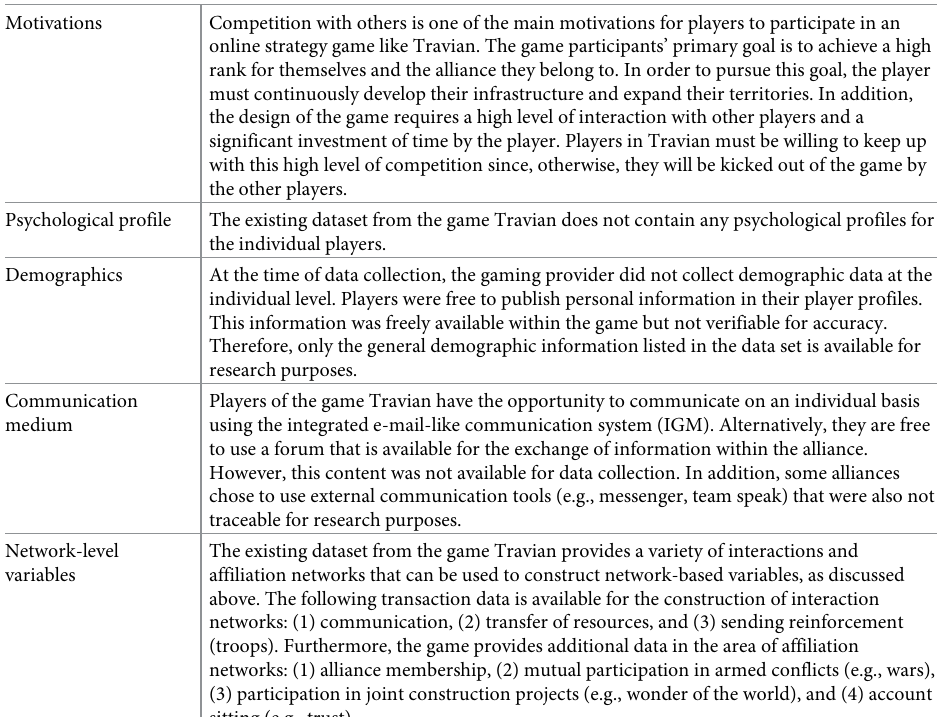
Table 1. The world of Travian—Traditional controls and independent variables based on Williams’ research agenda for virtual mapping and other tests.